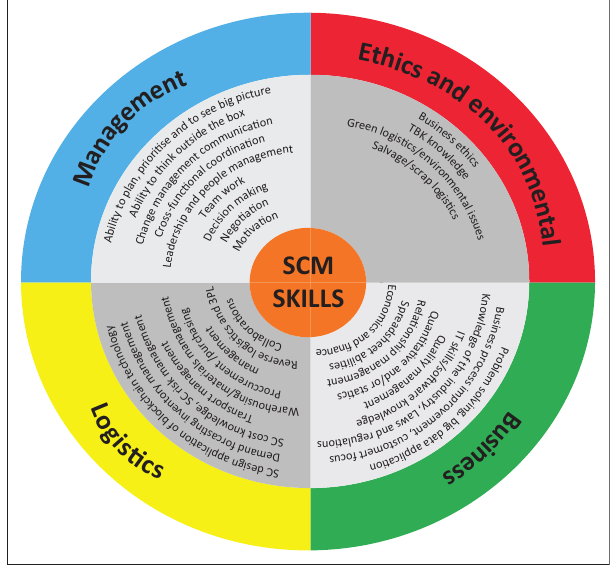
SCM, supply chain management; IT, information technology; SC, supply chain; TBL, triple bottom line. FIG URE 8: Proposed supply chain management skills framework.